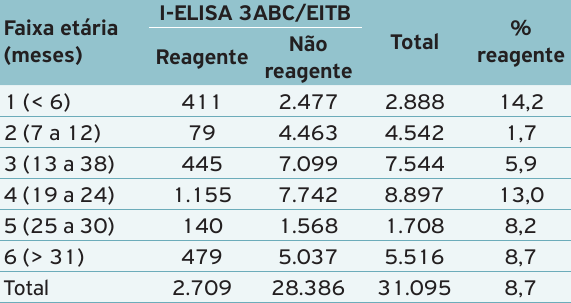
Tabela 2. Frequência de bovinos de propriedades rurais com anticorpos contra proteínas não capsidais do vírus da febre